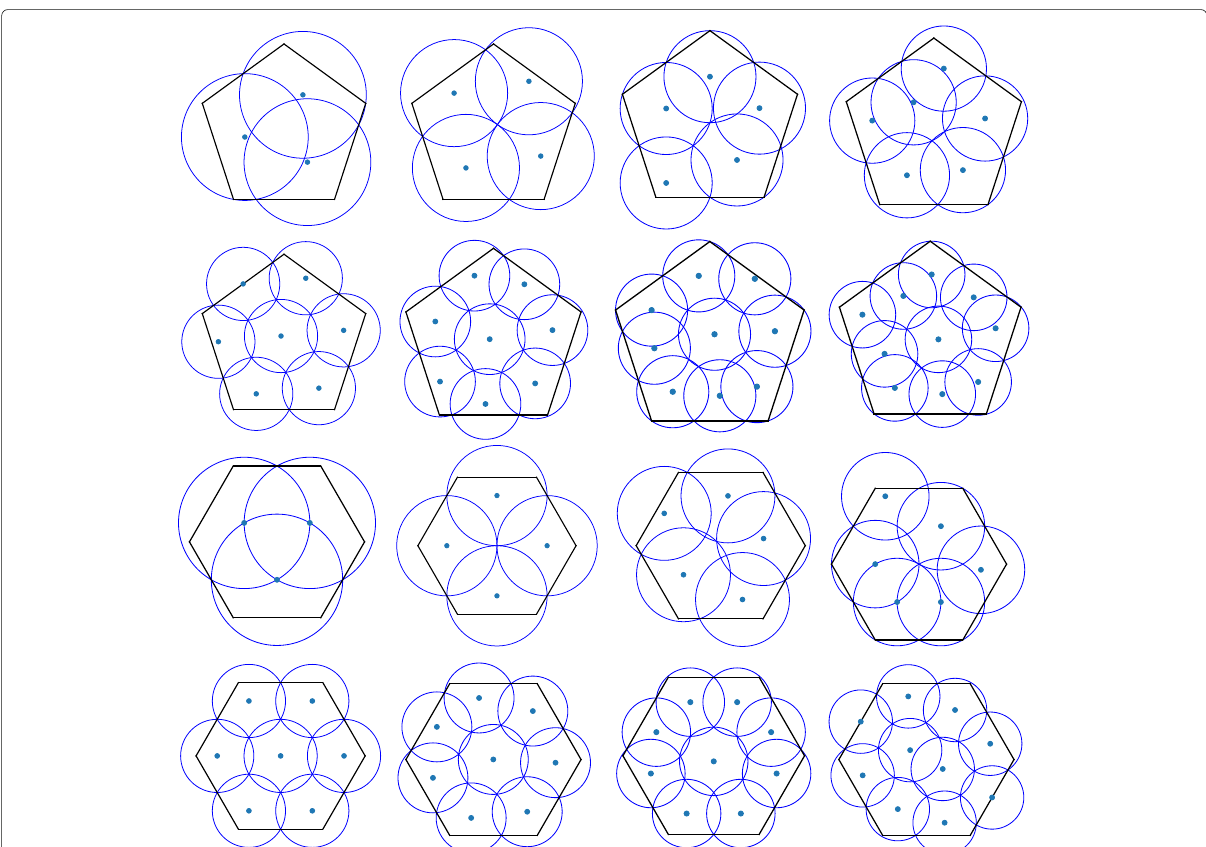
Fig. 9 Best solutions for the regular pentagon and regular hexagon areas covered by 3 to 10 centers. The solution may not be unique due to the symmetry of the area shape